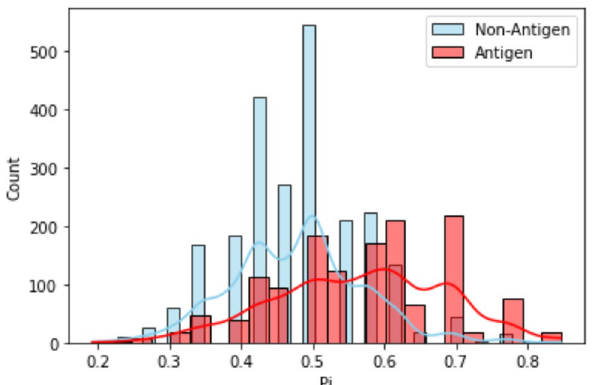
Figure 2. Frequency distribution of P i values based on the results from positive and negative datasets of bacteria, protozoa, fungi, and viruses. The Y-axis represents sequence count. The X-axis represents the *P i score values for each sequence. Blue depicts non-antigen and red antigen sequences. *P i stands for probability value where P i = S i /N (where, S i refers to the row-wise sum values and N refers to the total number of the